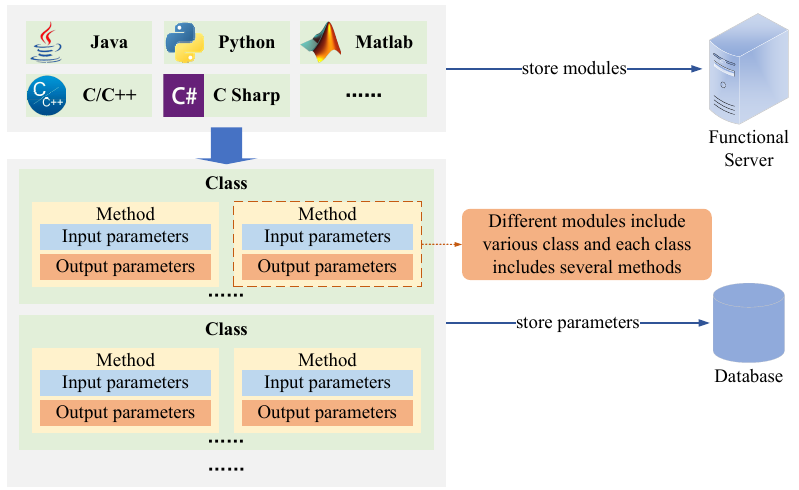
Figure 7. Storage of algorithmic and functional modules, components, and parameters. The various modules are stored on the functional server ready to be called, and the corresponding parameters are stored in the database for retrieving.